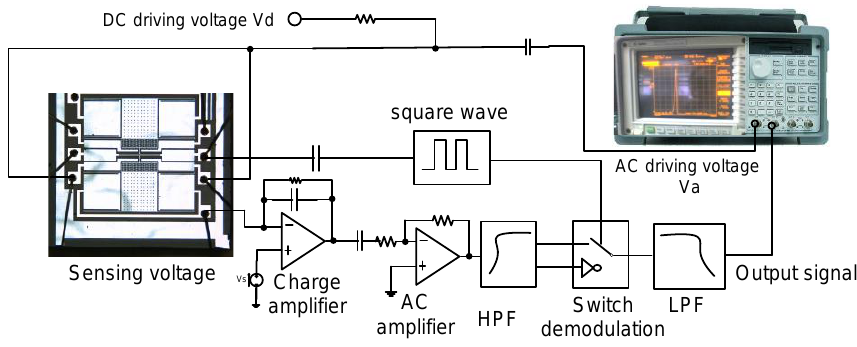
Figure 16. Open-loop test circuit.